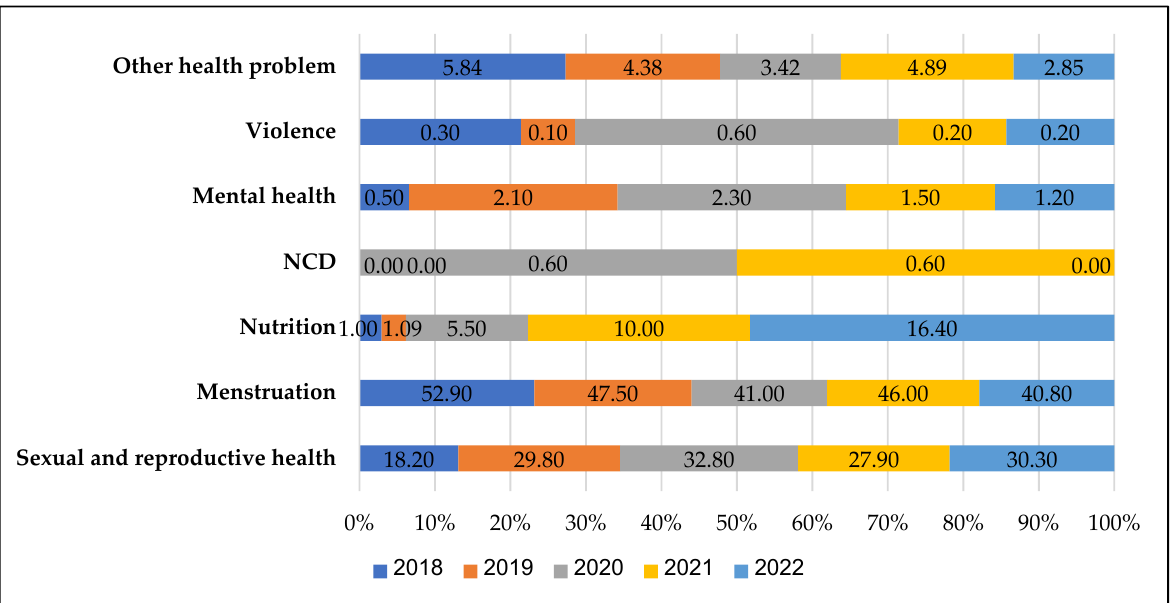
Figure 3. Year-wise counselling of beneficiaries by their health problems. Note: NCD: Non communicable diseases. NCD not reported in the 2018, 2019, and 2022 year.